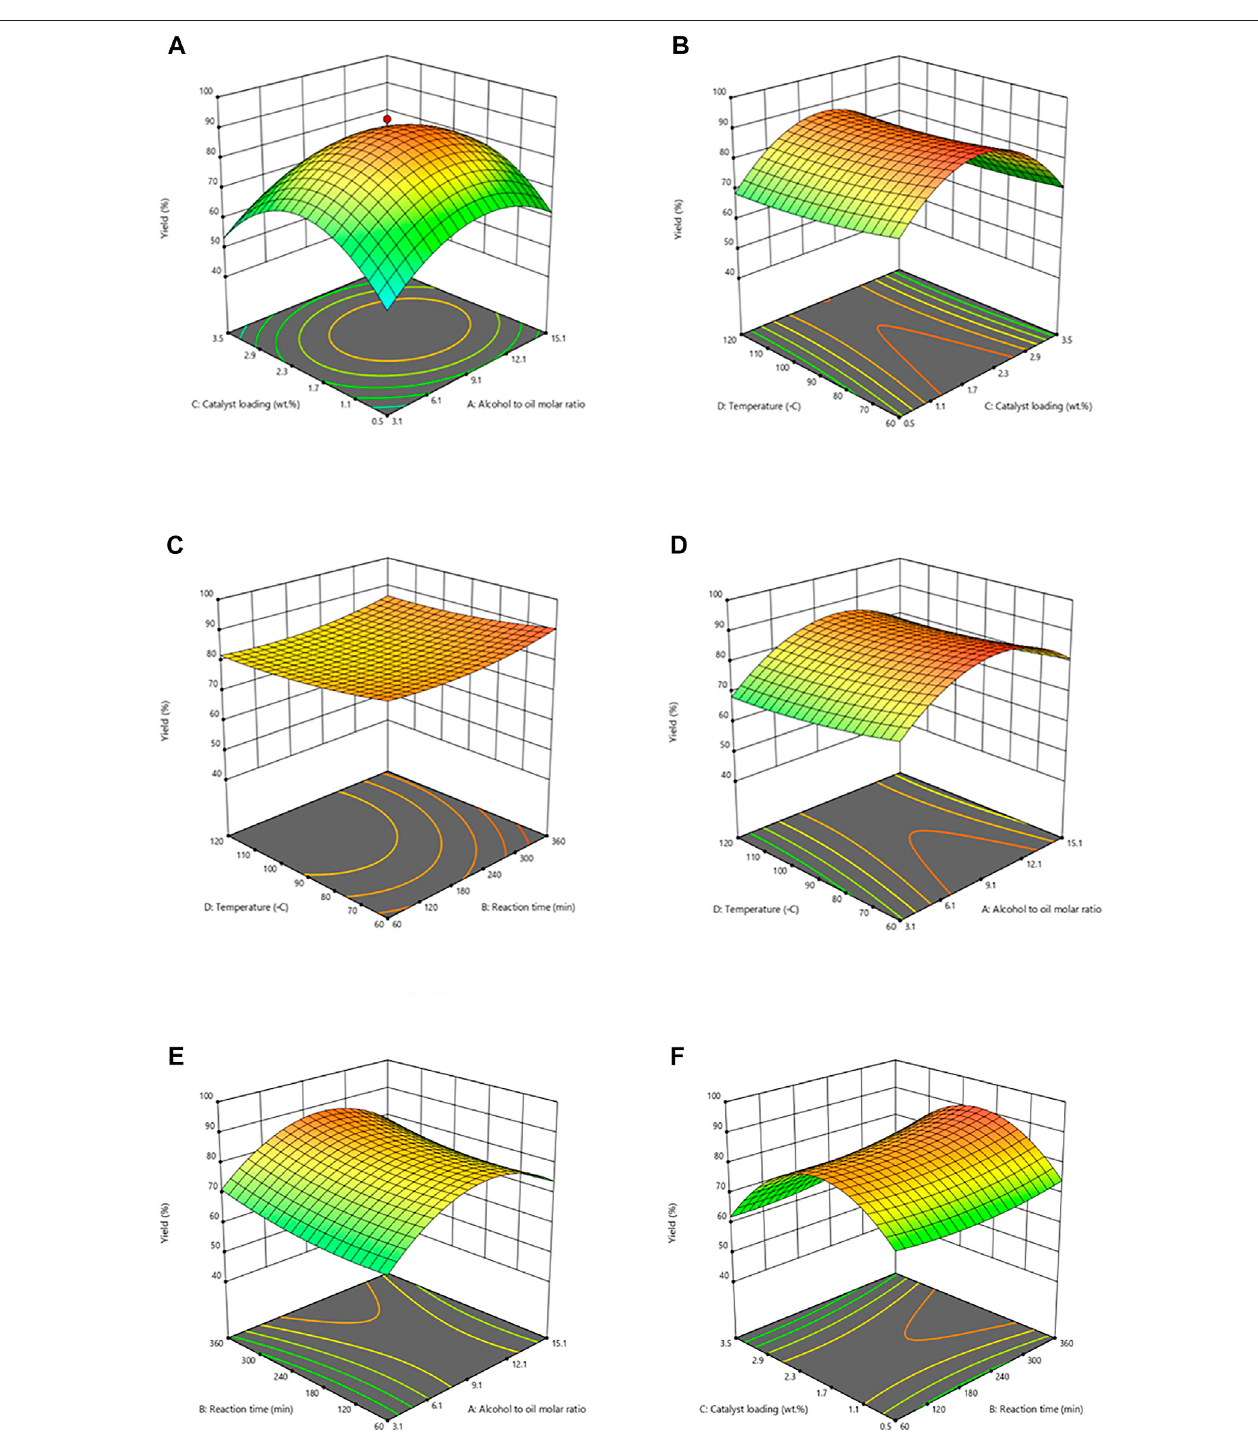
FIGURE 4 | In fl uence of reaction parameters on Cucumis melo var. agrestis biodiesel. (A) Catalyst loading vs alcohol to oil molar ratio, (B) Temperature vs catalyst loading, (C) Temperaturevsreactiontime, (D) Temperaturevsalcoholtooilmolarratio, (E) Reactiontimevsalcoholtooilmolarratio,and (F) Catalystloadingvsreaction time.